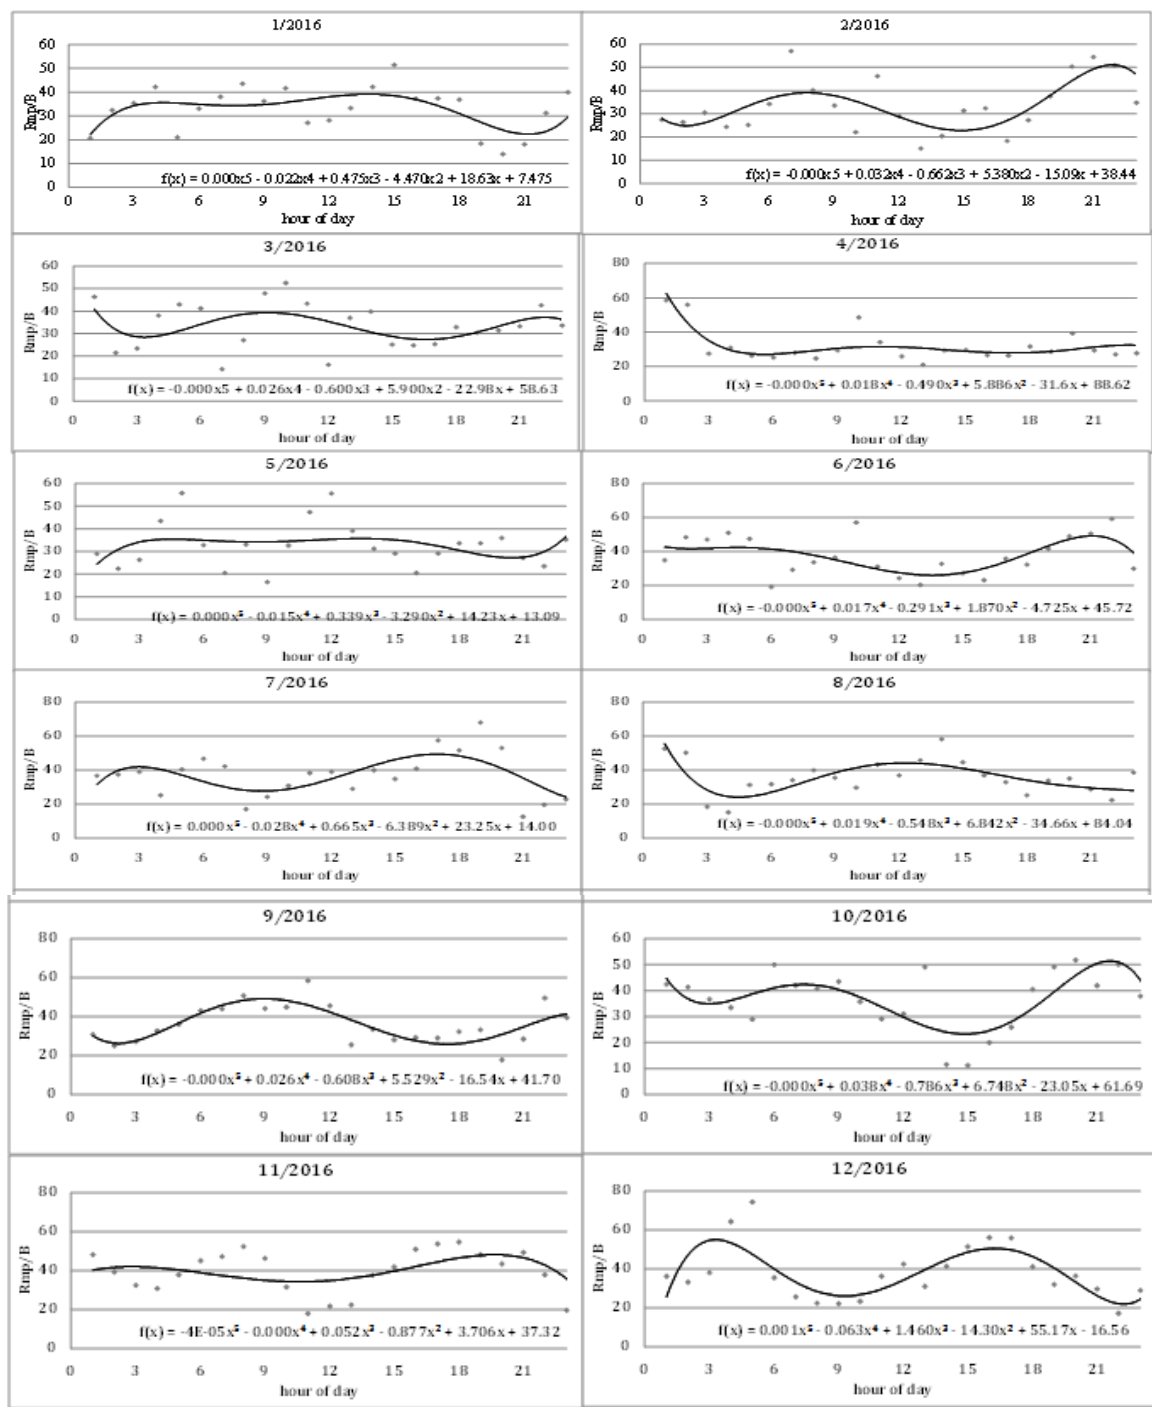
Fig. 3: Monthly median of (R